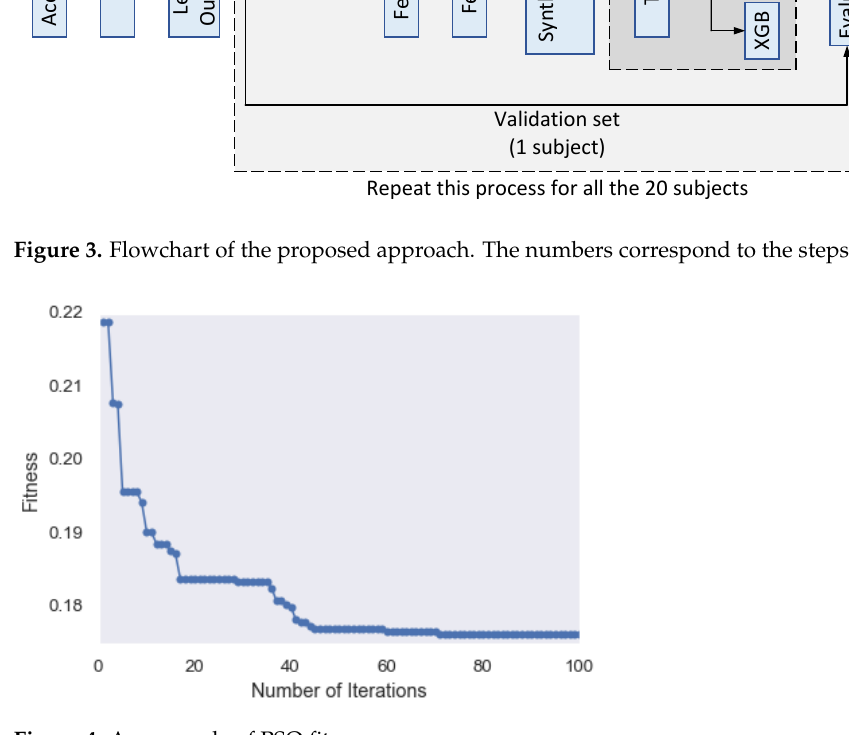
Figure 4. An example of PSO fitness